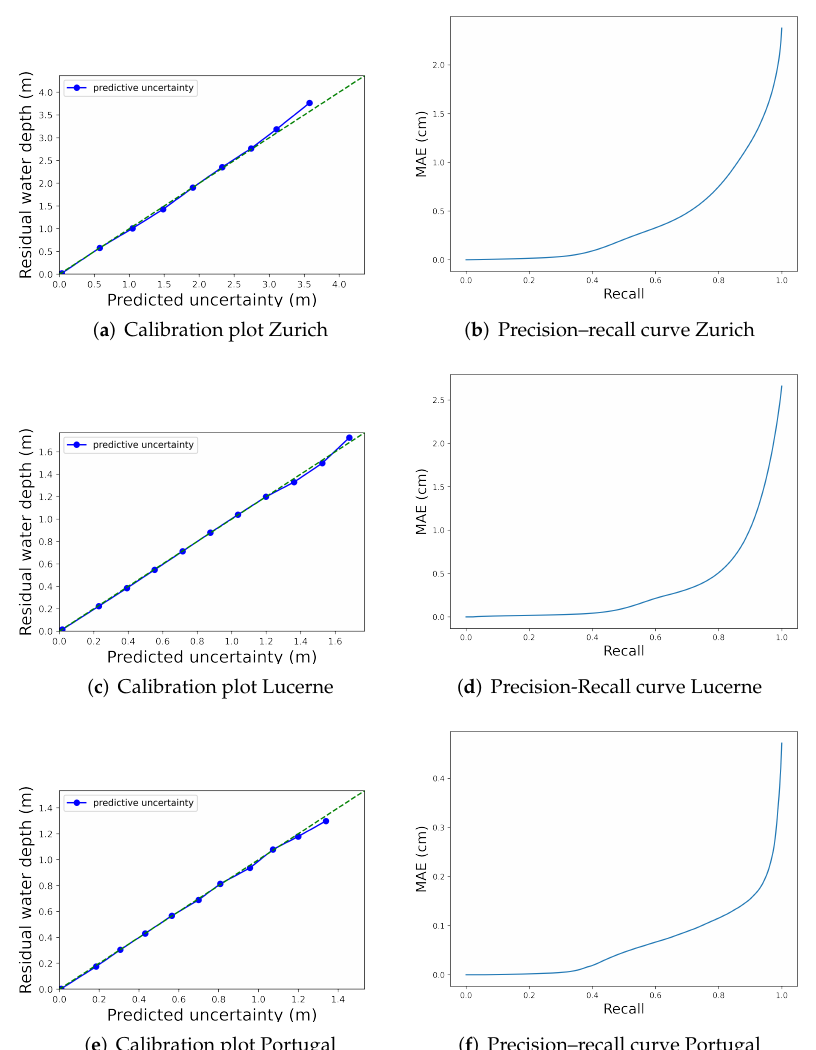
Figure 8. Evaluation of the predictive uncertainties predicted by Deep Flood for rainfall event tr2_1 on the Zurich, Lucerne, and Portugal test catchments. ( a ) The residuals in metres are plotted versus the grouped predicted uncertainties. ( b ) The test data are filtered based on the predictive uncertainty, showing a decrease in mean absolute error when high uncertainty test data points are